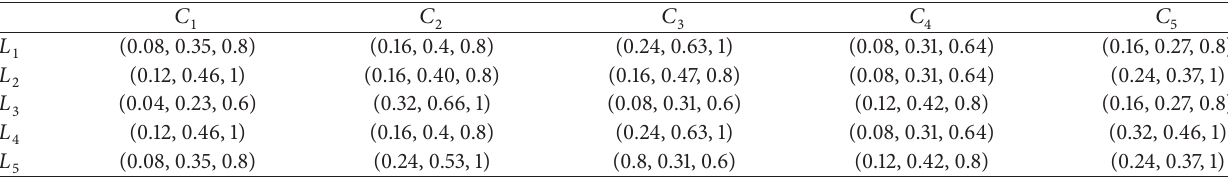
Table 7: Fuzzy weighted decision matrix.